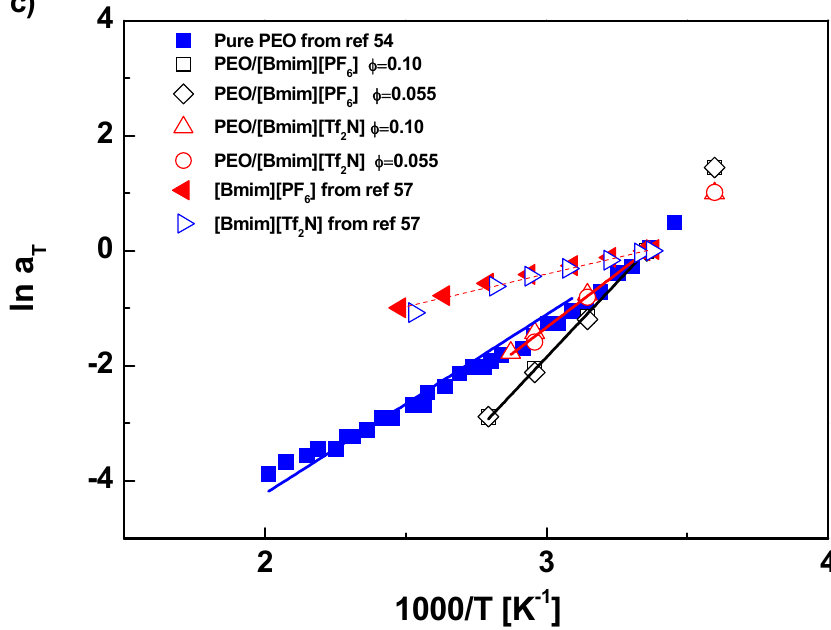
Figure 1. ( a ) Master curves of PEO in [Bmim][PF 6 ] and [Bmim][Tf 2 N] at T ref = 25 °C. ( b ) Horizontal shift factors a T as function of temperature T with WLF fitting. ( c ) a T as function of 1000/ T with Arrhenius fitting, where the lower temperature limit for fitting is 45, 25 and 25 °C for PEO, PEO/[Bmim][PF 6 ], and PEO/[Bmim][Tf 2 N], respectively.